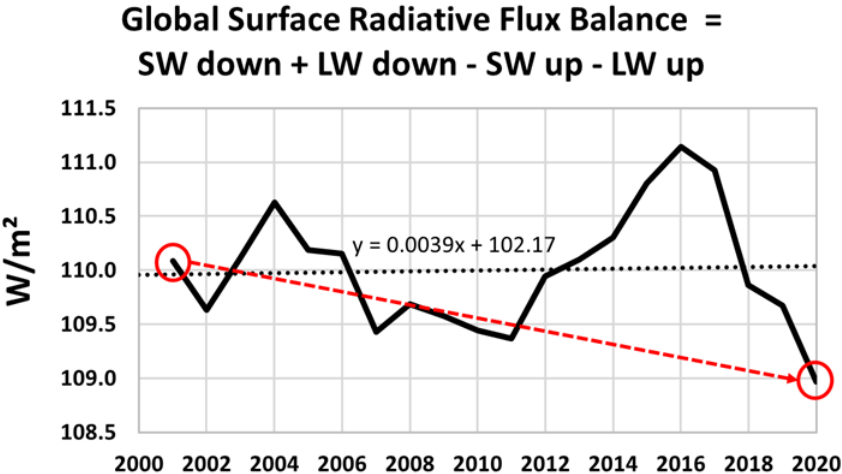
Figure 12. The global “All Sky” surface net flux shows no clear tendency. The 2020 value is below the 2001 value (arrow), and the mean trend is slightly positive but with overwhelming variance.